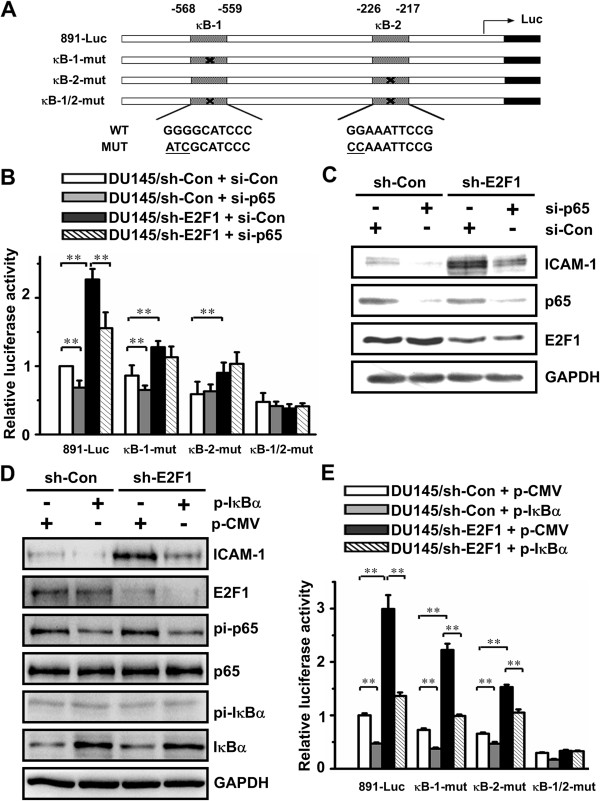
NF-κB binding sites are required for E2F1 regulation of ICAM-1 promoter. A. The histograph represent the human ICAM-1 promoter luciferase reporters used in this study. The location of each binding site on the promoter of ICAM-1 is indicated and labeled. The crossed boxes indicate the mutation sites on each construct. The mutated nucleotides corresponding to κB-1-mut and κB-2-mut are underlined. B and C. DU145/sh-Con and DU145/sh-E2F1 cells were co-transfected with duplex siRNA targeting p65 and either ICAM-1 wild type or mutant promoter reporters. The stars indicate the significant differences (P < 0.05) (B). The expression of membrane ICAM-1 was measured by Western blot (C). The data are shown as the mean ± SD of triplicate measurements. D and E. DU145/sh-Con and DU145/sh-E2F1 cells were transiently transfected with either the empty vector or the mutant IκBα expressing plasmids. The phosphorylation of p65 and IκBα and the expression of ICAM-1 in these indicated cells were monitered by Western blot (D). DU145/sh-Con and DU145/sh-E2F1 cells were co-transfected with IκBα expressing plasmids and either the ICAM-1 wild type or mutant promoter reporters for the luciferase activity assay (E). The results are shown as the mean ± SD of triplicate measurements. The stars indicate the significant differences (P < 0.05).